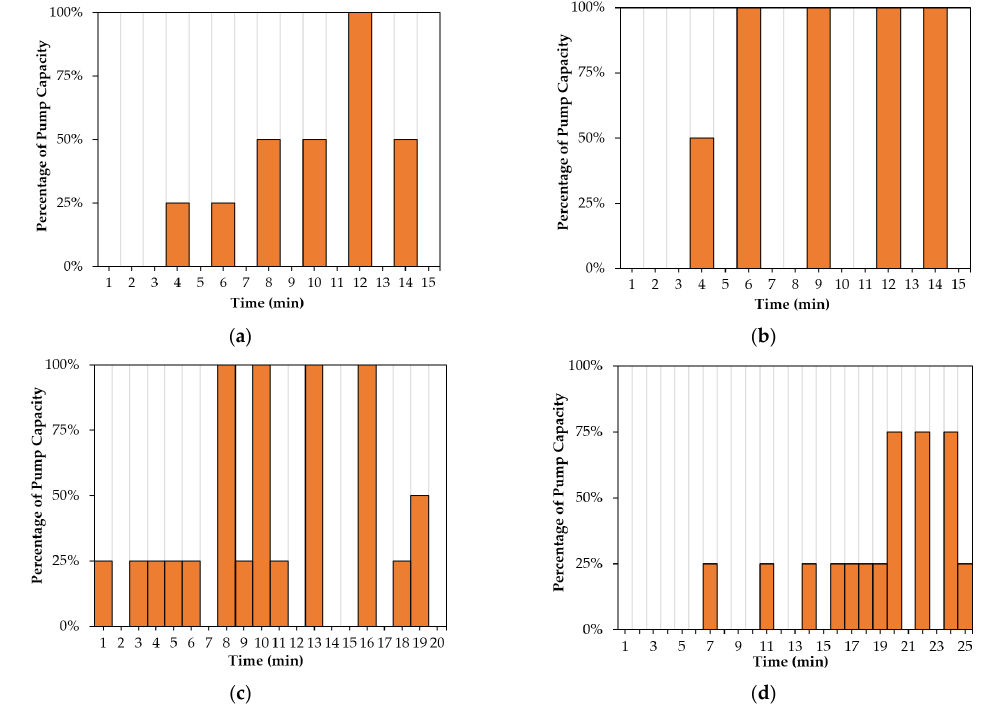
Figure 7. DRL actions during different rainfall events: ( a ) 15 min-constant; ( b ) 15 min-normal; ( c ) 20 min-descending; ( d ) 25 min-ascending.